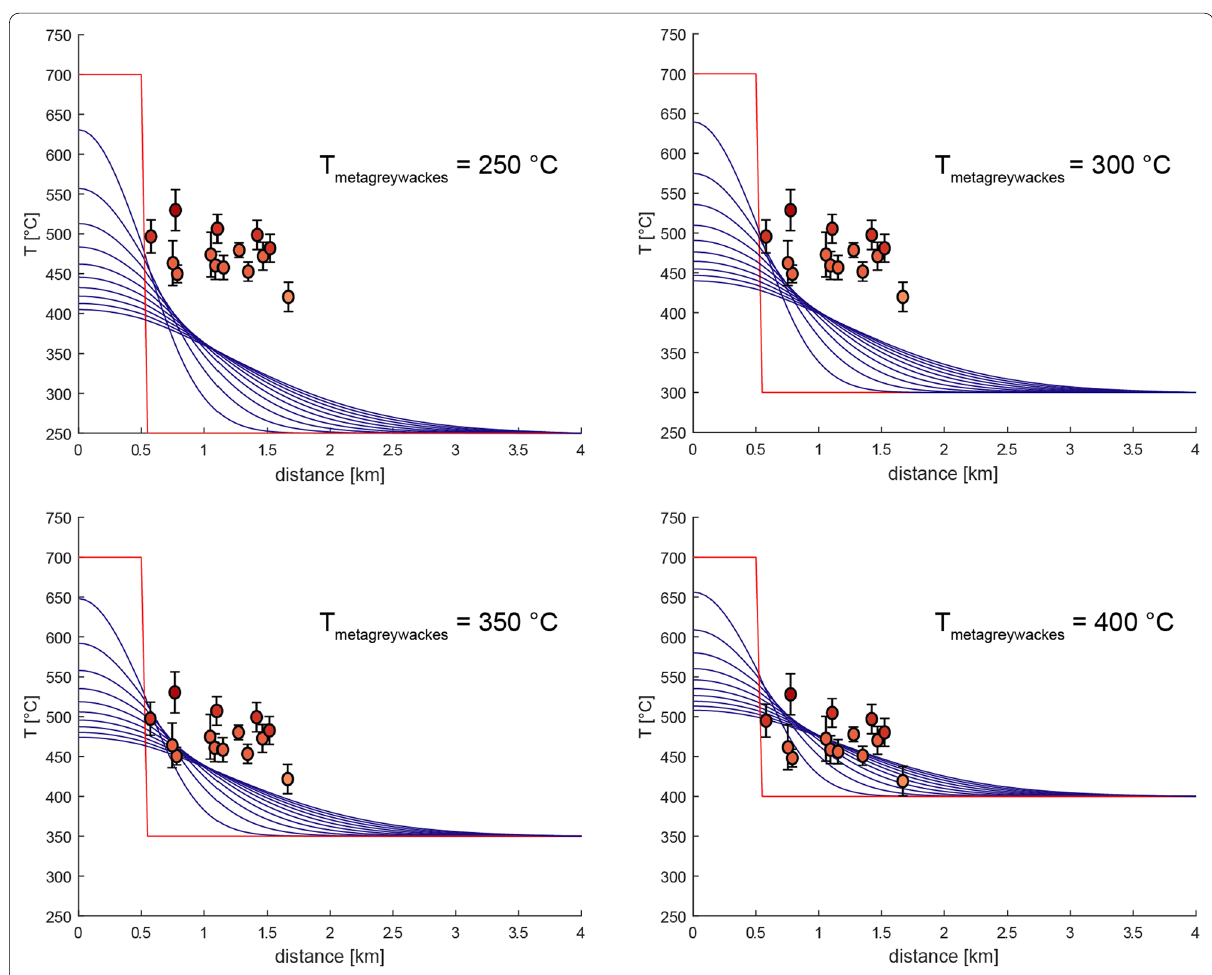
Fig. 8 Numerical models of the thermal diffusion of the Montées‑Pélissier granite within metagreywackes at initial temperatures of 250, 300, 350 and 400 °C. Models last 50 kyr. Red lines: initial geotherms; Blue lines: geotherms every 5 ka. RSCM temperatures from the western side of the Servoz syncline are